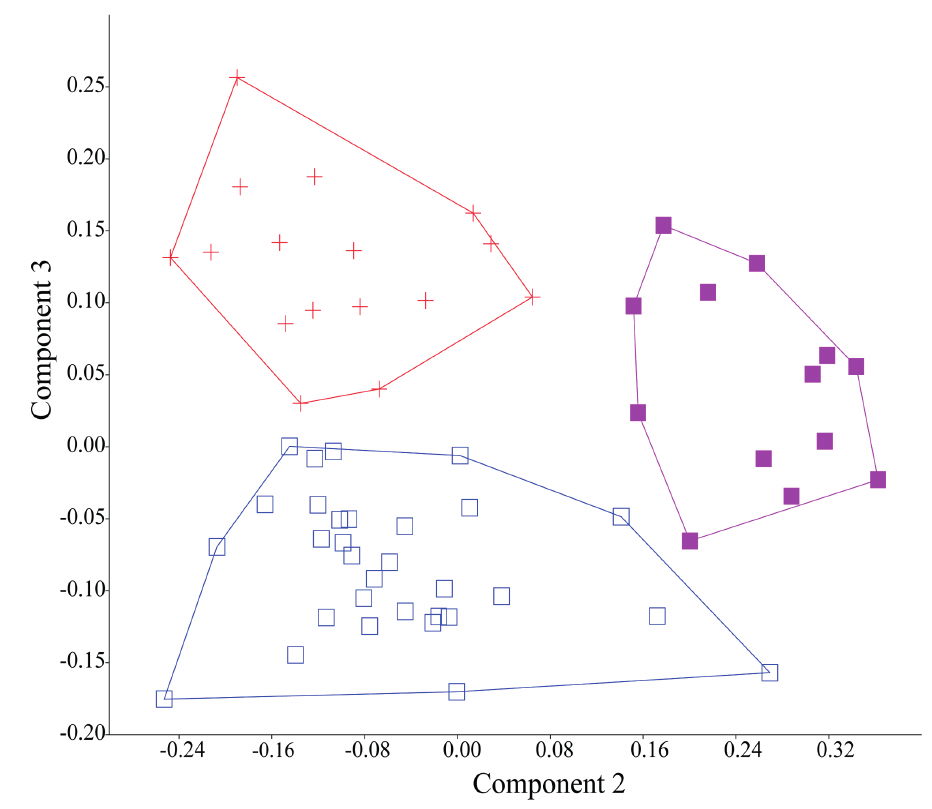
FIGURE 8 | Second and third principal components axes of combined samples of Rhyacoglanis varii (red cross, n = 16), R. paranensis (blue square; n = 31), and R. rapppydanielae (pink square; n = 13).